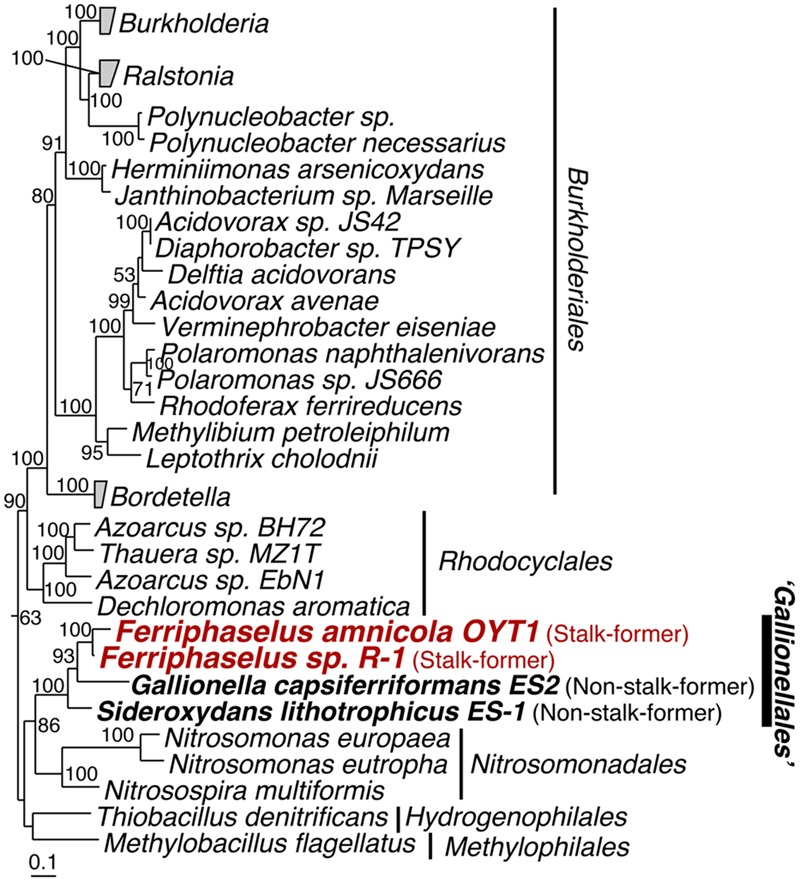
Phylogenetic tree of concatenated amino acid sequences of 14 ribosomal proteins (RplA, RplB, RplC, RplD, RplE, RplF, RplK, RplM, RplN, RpsB, RpsC, RpsI, RpsJ and RpsS). Bootstrap values (>50 of 100 replicates) are shown at the branch points. The concatenated amino acid sequence of these proteins of Escherichia coli K12 was used as the out-group (not shown).